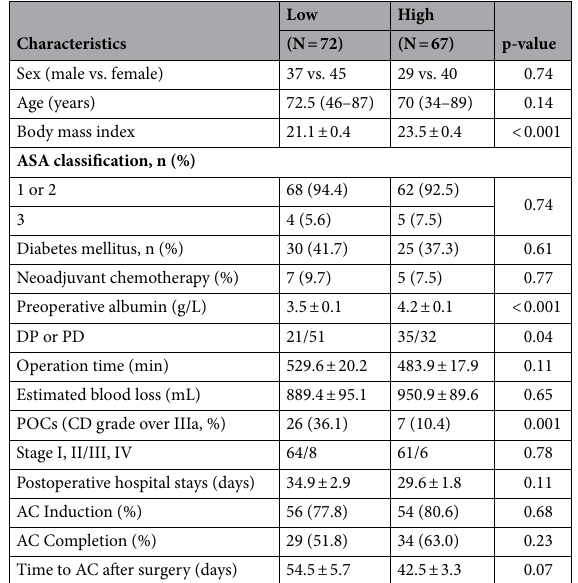
Table 2. Comparison of patient characteristics between the study groups. ASA, American Society of Anesthesiologists; DP, distal pancreatectomy; PD, pancreatoduodenectomy; POCs, Postoperative complications; AC, adjuvant chemotherapy.